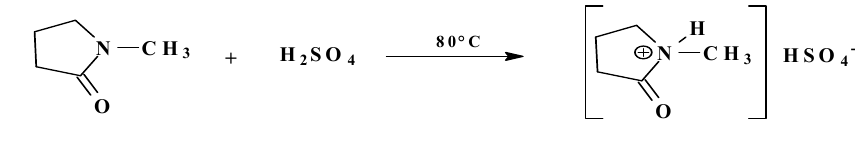
Figure 1. Synthesis of [HNMP] HSO 4 .